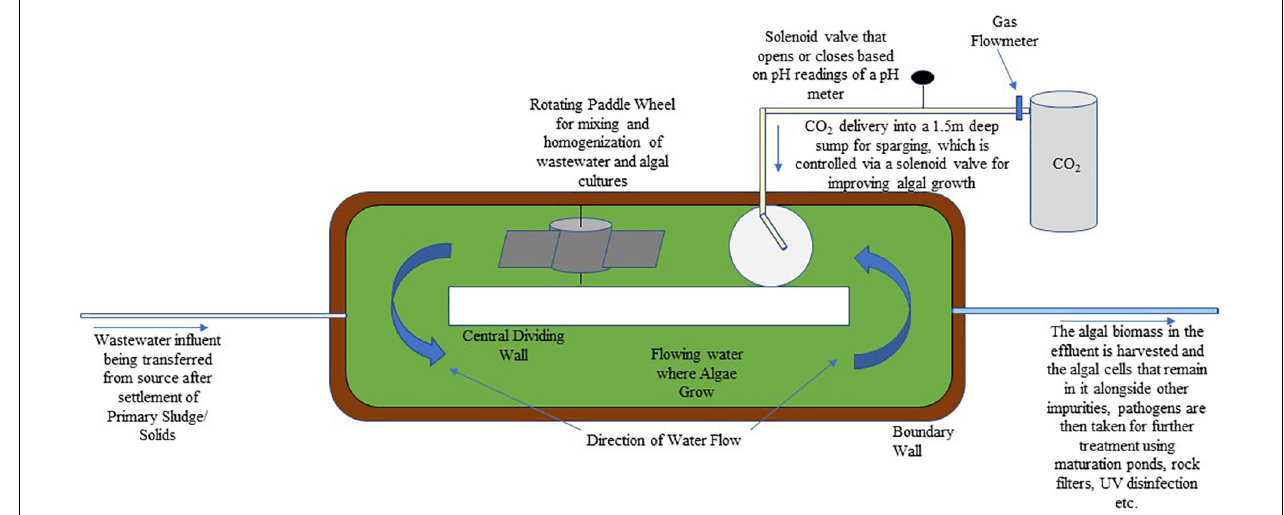
FIGURE 2 | A schematic showing a high-rate algal pond that has a CO 2 addition function for improving algal growth.